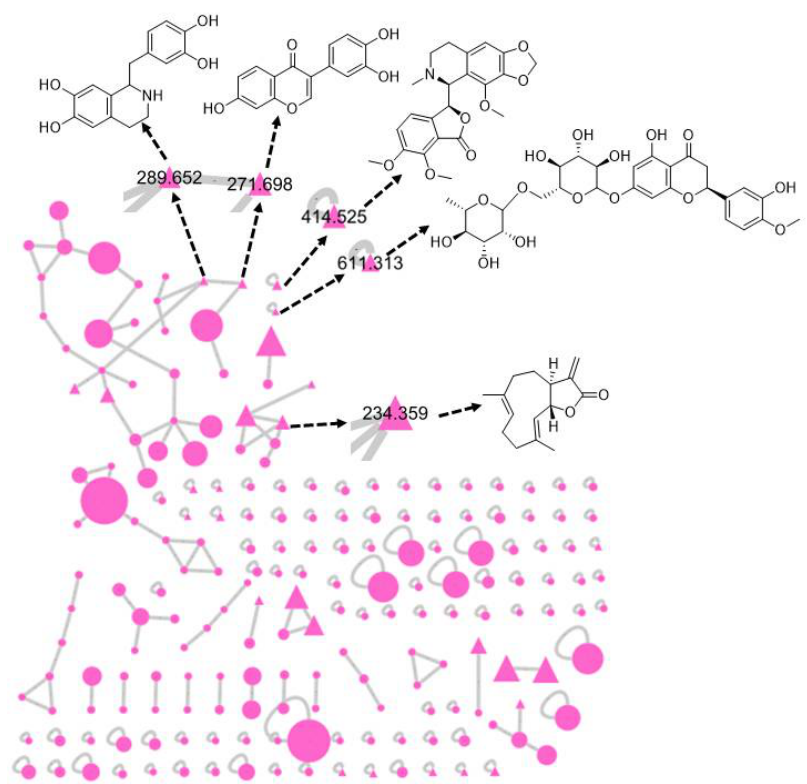
Figure 11. Molecular network of 195 parent ions produced from A. senegal . The circular fuchsia nodes refer to the whole parent masses that have unique detected peaks in the molecular network. The triangle fuchsia Nodes represent parent ions that have been identified in the GNPS molecular network. Table 1. The precursor and fragments’ masses of the identified metabolites compared with that of the standards from the molecular networking database.